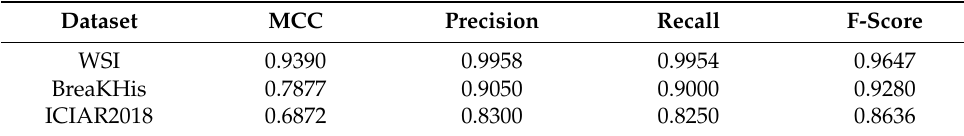
Table 5. Performance metrics 2 of ResNet101 with the different datasets used.